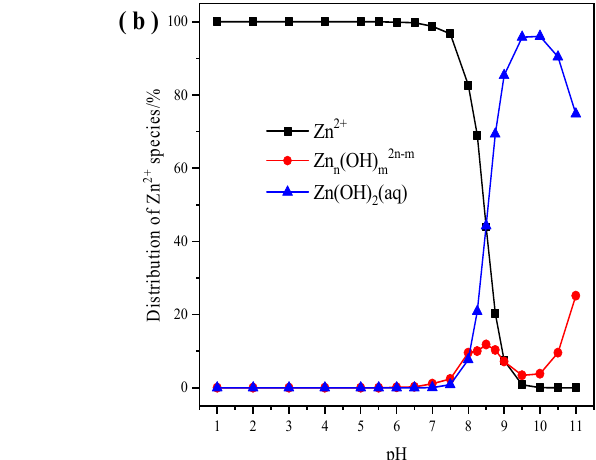
The morphology of X zeolite and samples after adsorption with Cu 2+ and Zn 2+ are